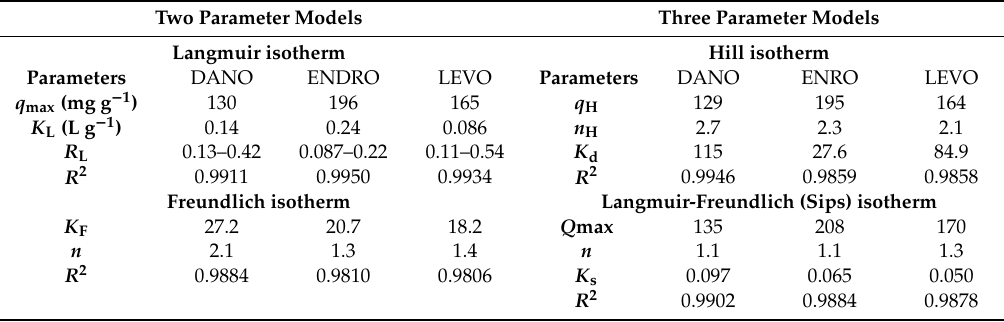
Table 5. Isothermal parameters of DANO, ENRO and LEVO on MMPC / Cyc-Chit.